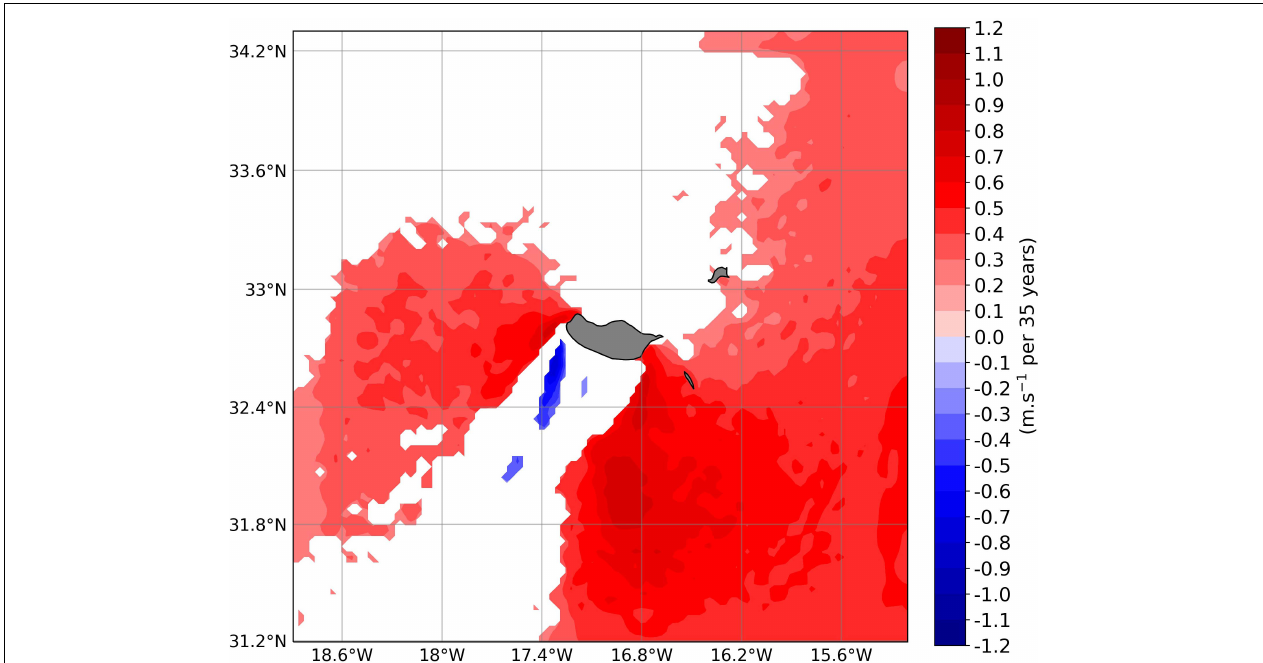
FIGURE 11 | Summer (JJA) (1983–2017) wind speed trend, computed with the Theil–Sen method. Only zones with the same sign in the 95% upper and lower bounds are shown.